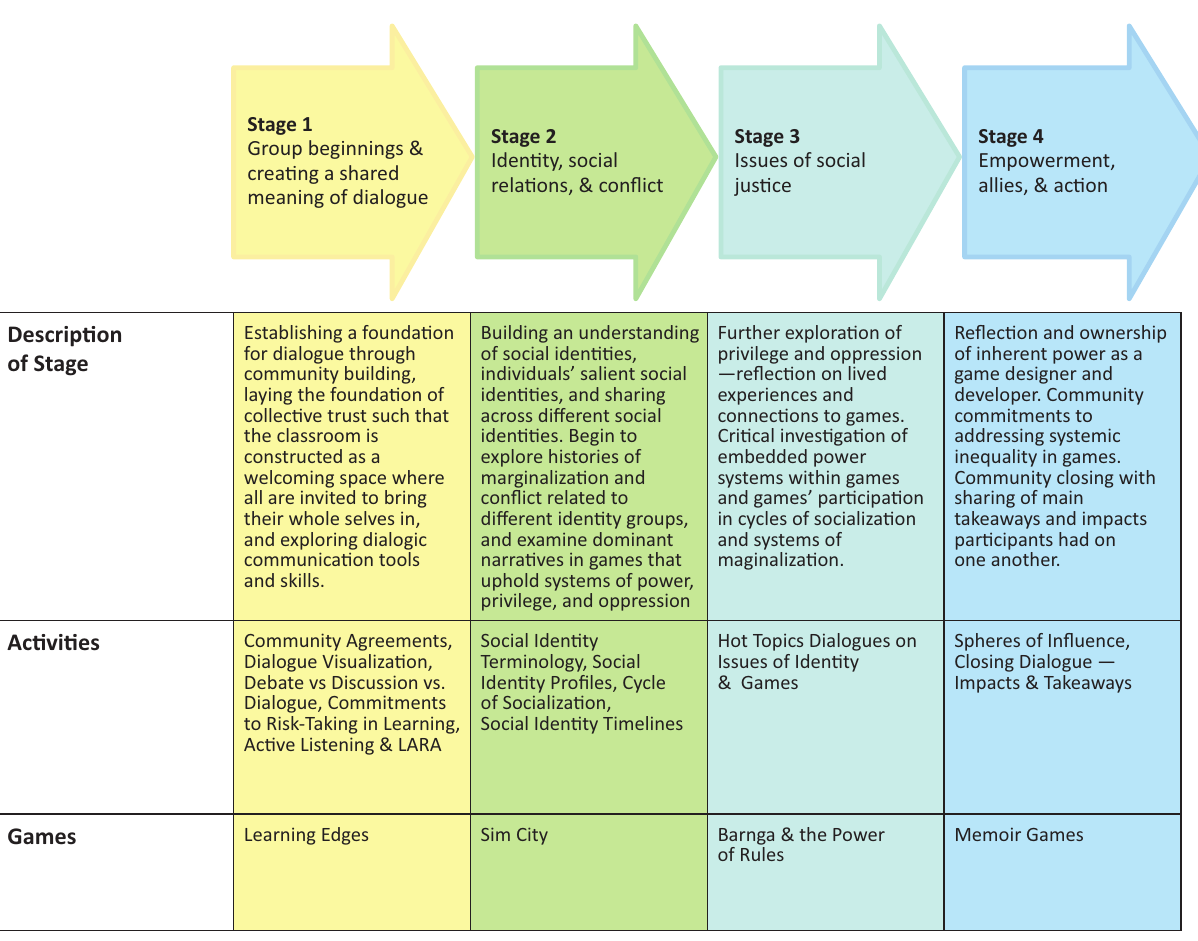
Figure 1. The four stages of dialogue as implemented in our